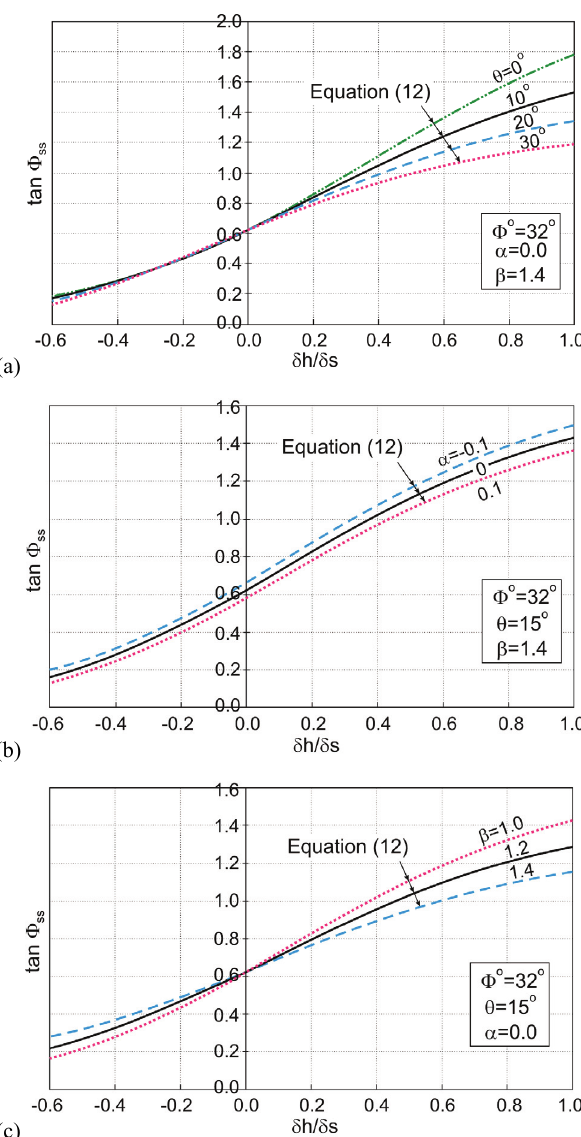
Fig. 2. Influence of  ,  and  on the stress ratio-dilatancy relationship: (a)  = 0, 10, 20, and 30 degrees; (b)  = –0.1, 0, and 0.1; (c)  = 1.0, 1.2, and